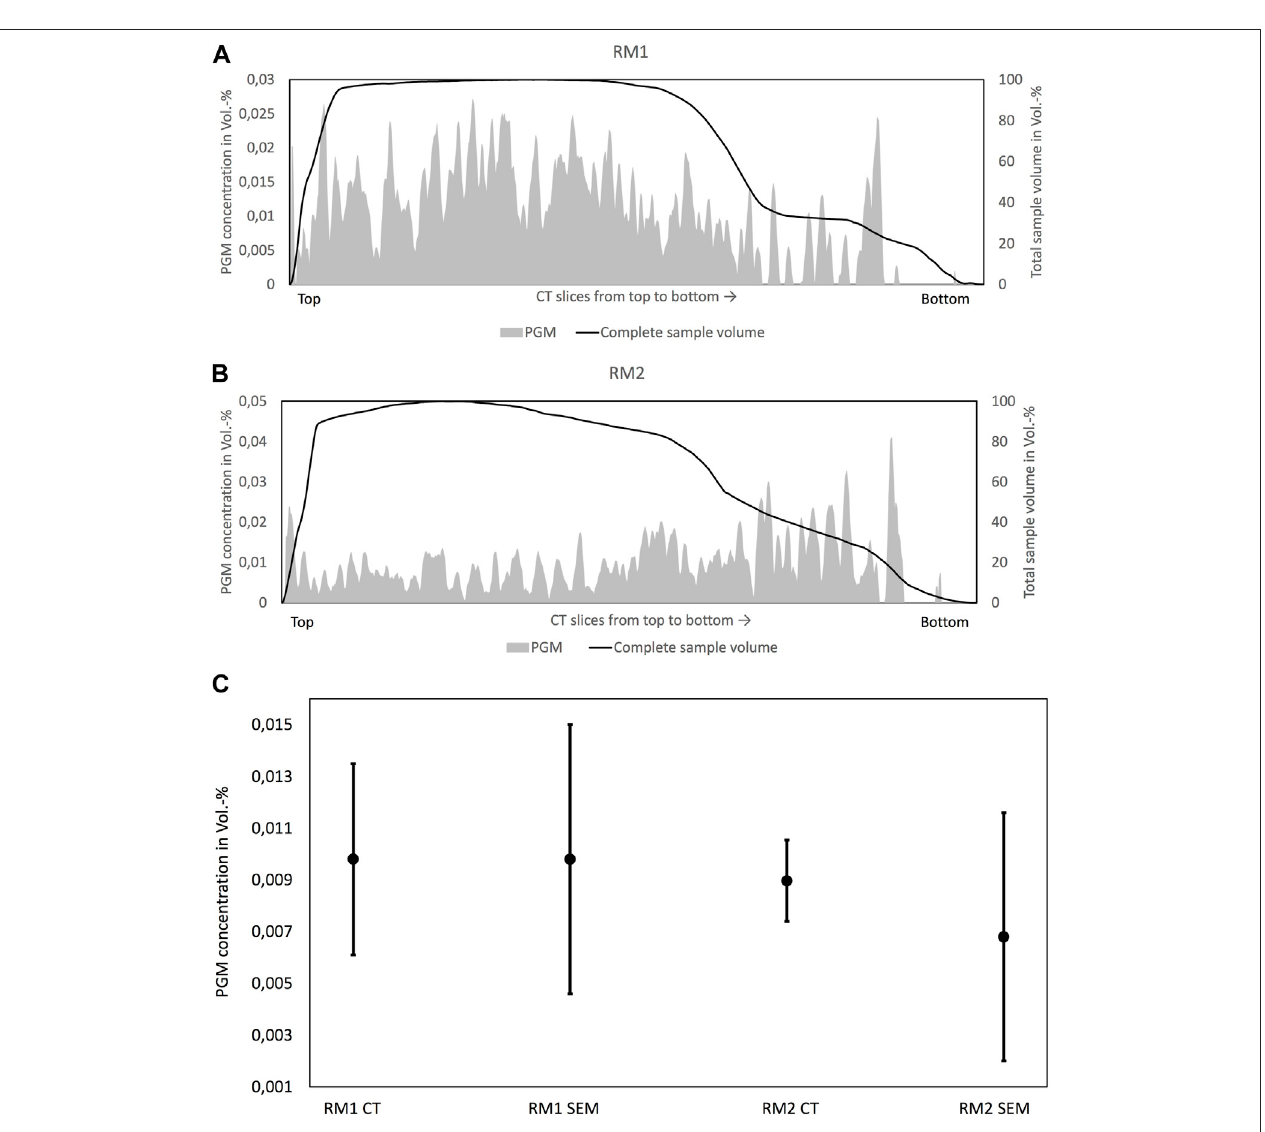
FIGURE 6 | Concentration of PGM and complete sample volume per measured CT slice of samples RM1 (A) and RM2 (B) and comparison of calculated PGM concentrations for samples RM1 and RM2 based on micro-CT and stereological corrected SEM-EDS measurements with sigma 1 (C) .